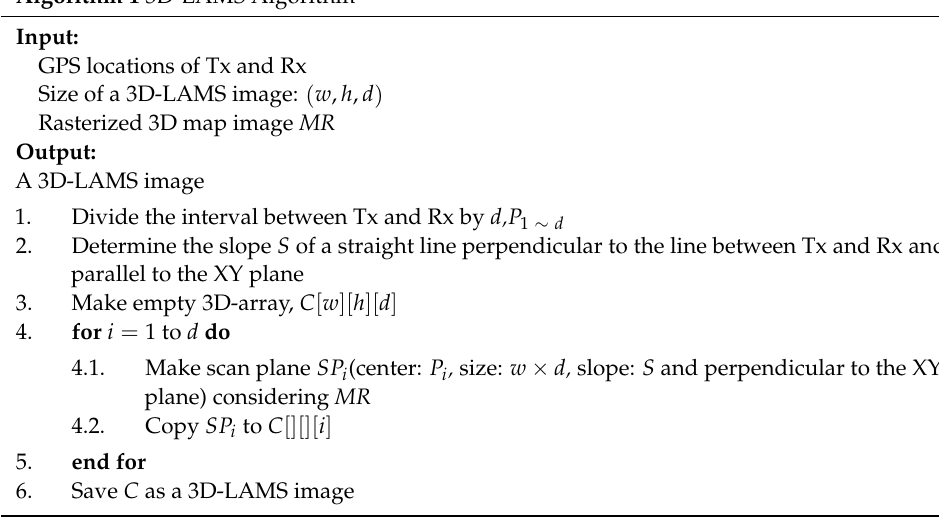
Algorithm 1 3D-LAMS Algorithm